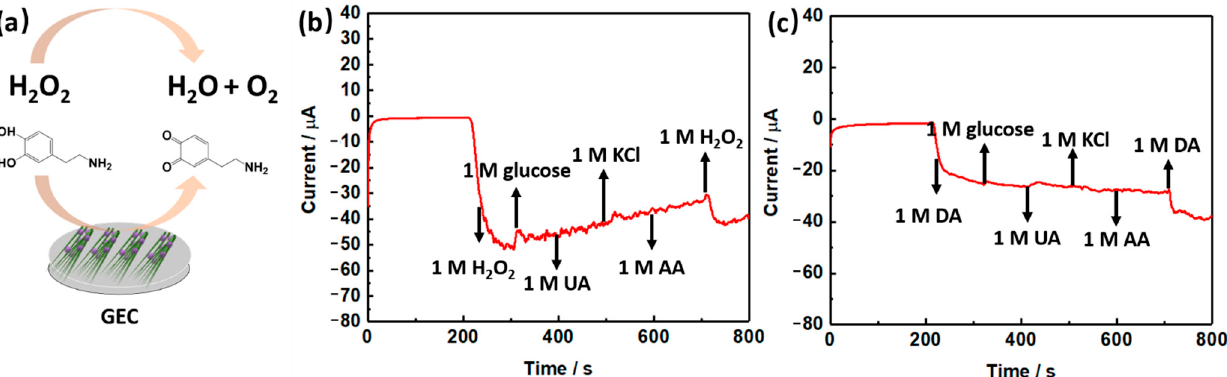
Figure 6. ( a ) The mechanism of electrochemical biosensor detection of H 2 O 2 and dopamine. ( b ) The selective ability test of the Co 3 O 4 /NiCo 2 O 4 electrochemical biosensor to H 2 O 2 and ( c ) DA.